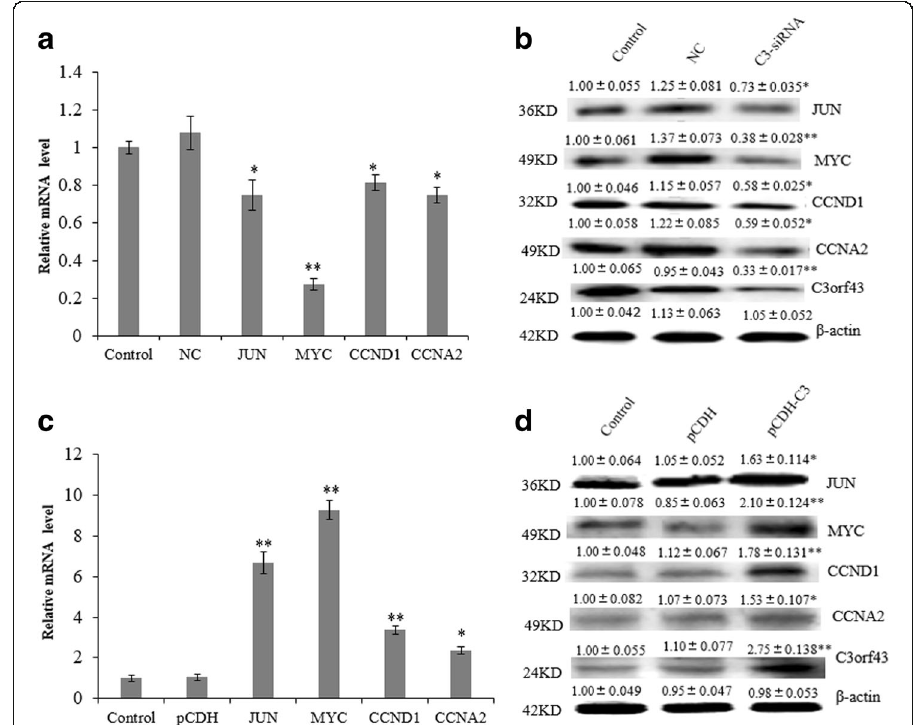
Fig. 4 The effect of C3orf43 on BRL-3A cell proliferation-related genes. a The expressions of cell proliferation-related genes were assessed using qRT-PCR 48 h after transfection with siRNA. b The contents of cell proliferation-related genes were assessed using western blot 48 h after transfection with siRNA. c The expressions of cell proliferation-related genes were assessed using qRT-PCR in cells with overexpression of pCDH-C3orf43. d The content of cell proliferation related genes were assessed using western blot in cells with overexpression of pCDH-C3orf43. The experiments were performed three times. The data are shown as the means ± SD. Representative images are shown. * p < 0.05, ** p < 0.01 difference relative to the